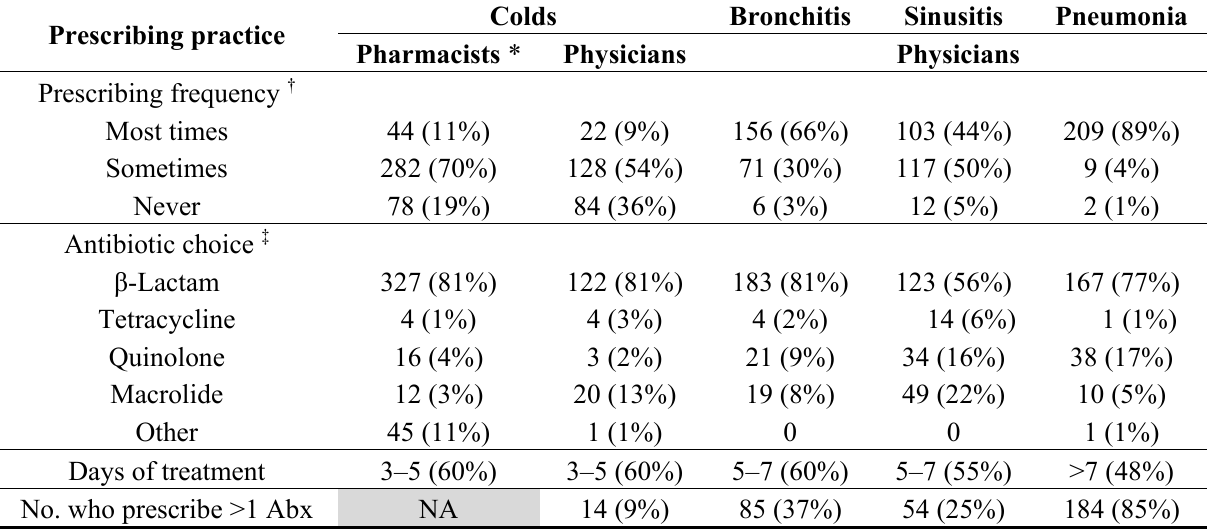
Table 2. Self-reported antibiotic prescribing practices for various acute respiratory infections (ARIs), physicians and pharmacists, Minya District, Egypt,